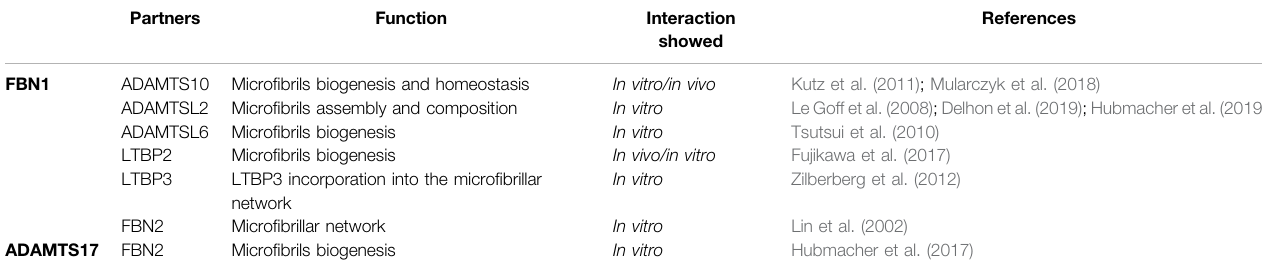
TABLE 2 | In vitro and in vivo fi brillins